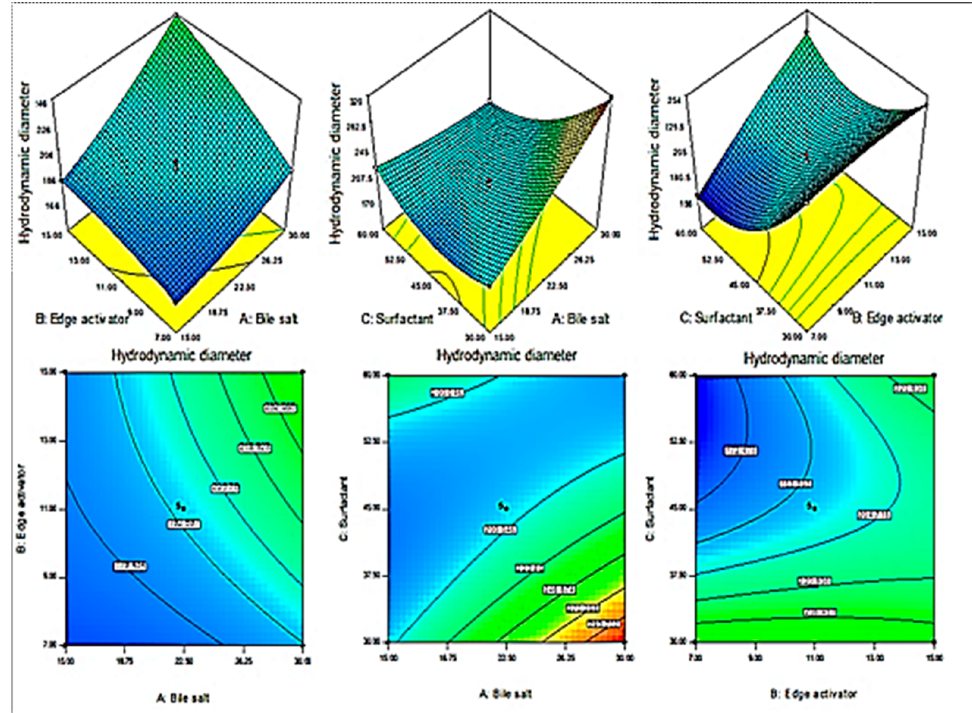
Figure 2. Effect of independent variables sodium deoxycholate (A), Cremophor EL (B), and Span 60 (C) on hydrodynamic diameter (Y 1 ).